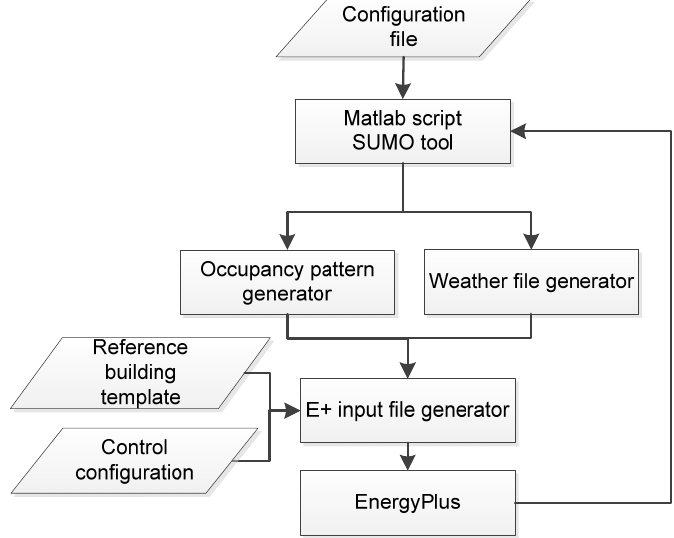
Figure 6. Structure of the implementation